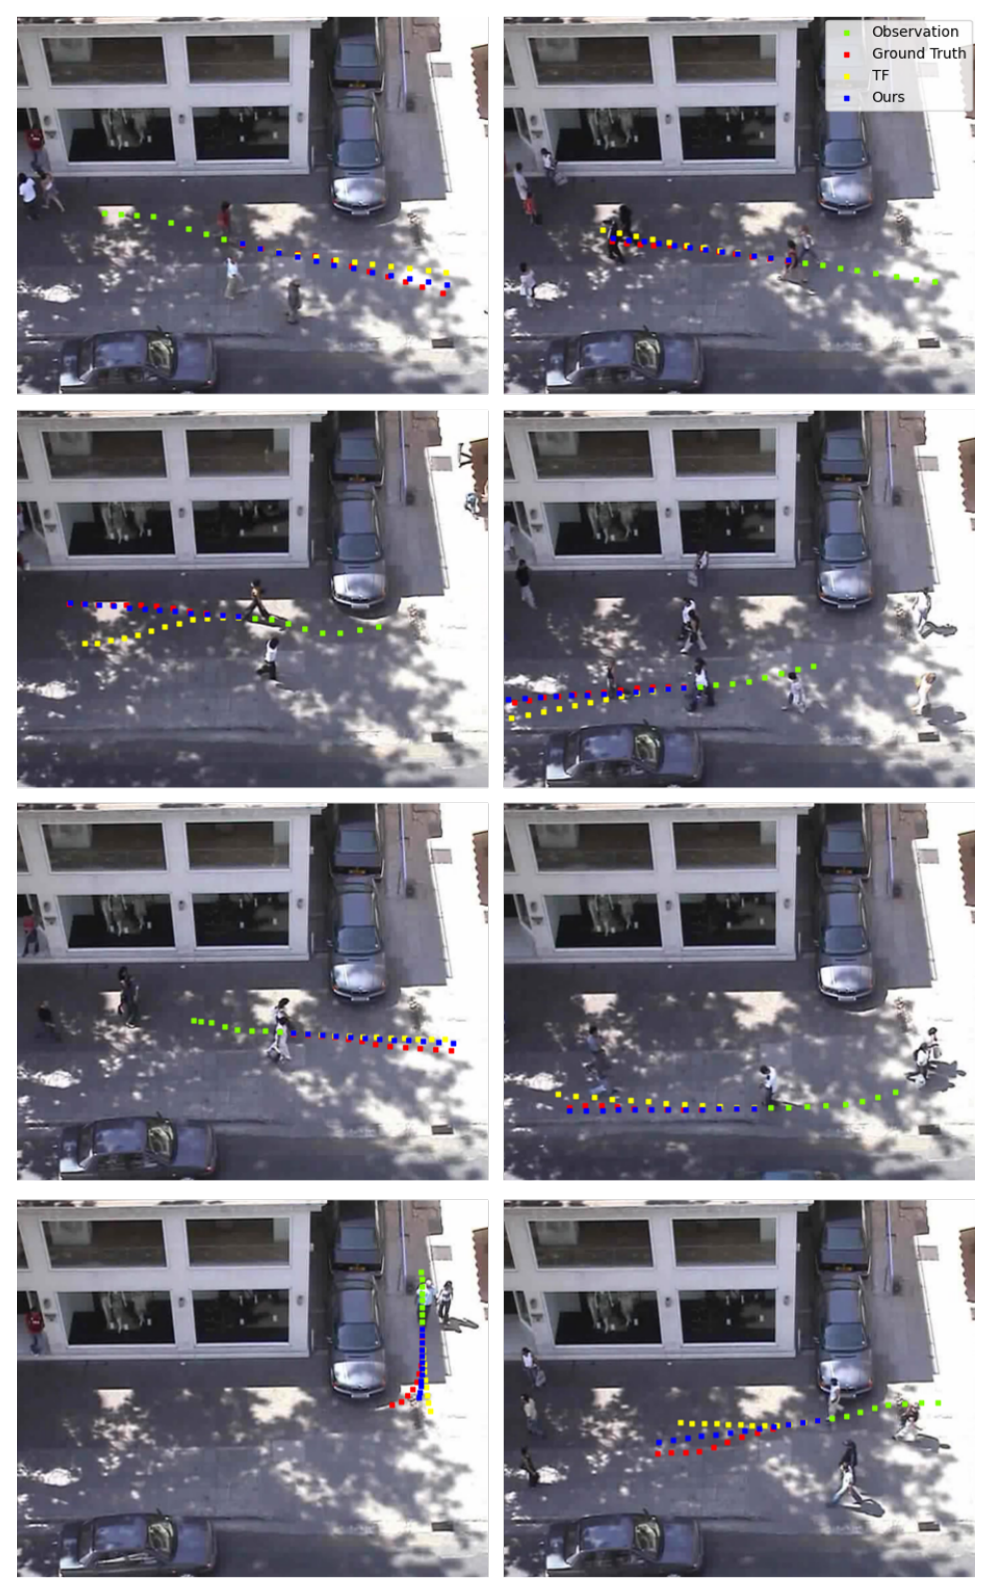
Figure 2. Qualitative comparison between the proposed method with TF predicting trajectories. The results are shown on Zara1 dataset. The first 3 rows show examples where the proposed method successfully predicts the trajectories with small errors. The last row shows some suboptimal cases, e.g., a person took a linear path. Even so, the proposed method predicts a plausible